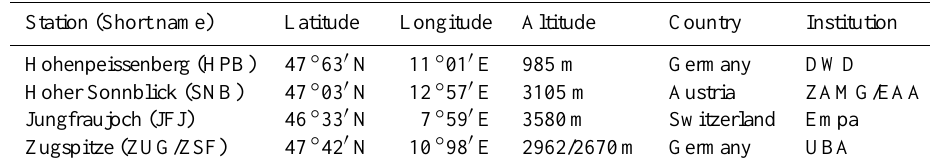
Table 1. Locations of the four DACH